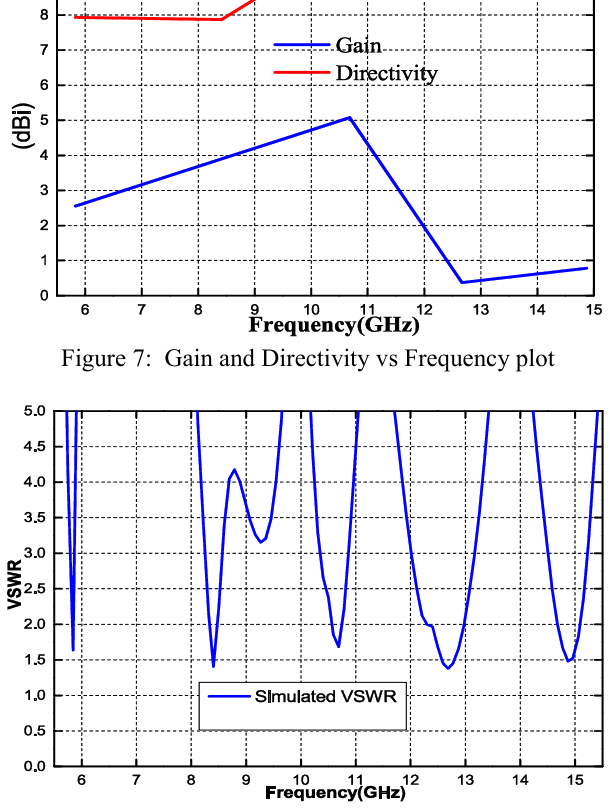
Figure 8: VSWR vs Frequency Plot